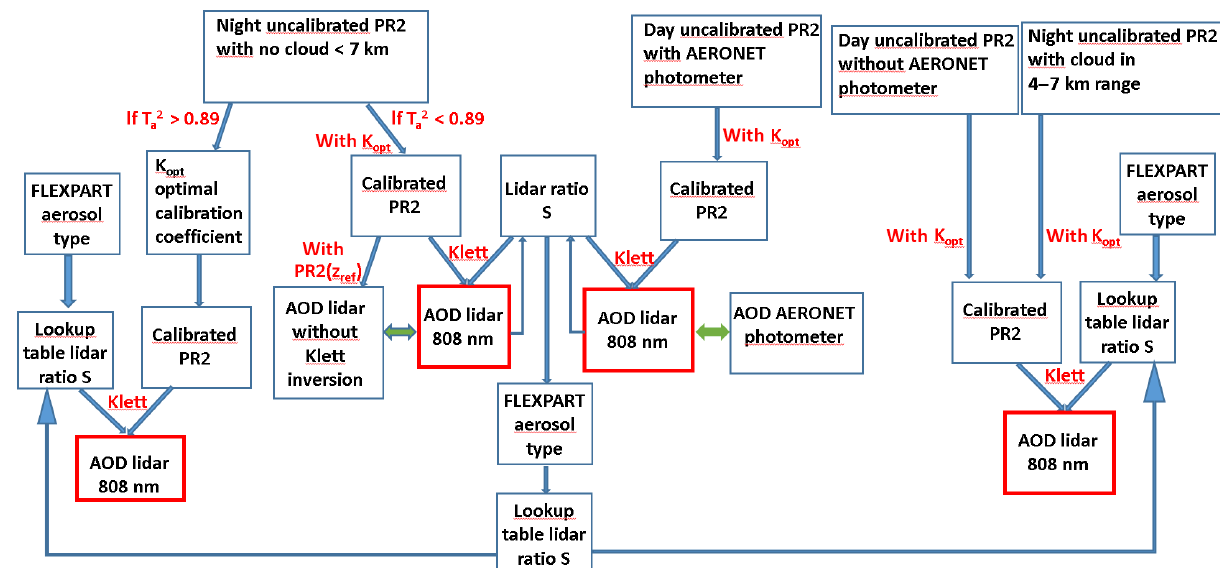
Figure 4. Flow chart of the lidar range-corrected signal (PR2) processing to derive the 800nm aerosol optical depth (AOD) up to the reference altitude ( z ref ). Four different calibrations and AOD calculations are used according to the measurement conditions. Iteration between the AOD calculation and the lidar ratio value is only possible when the AOD is compared to an external AOD reference (green two-sided arrows).